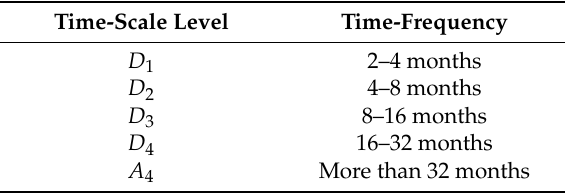
Table A2. Time interpretation of different